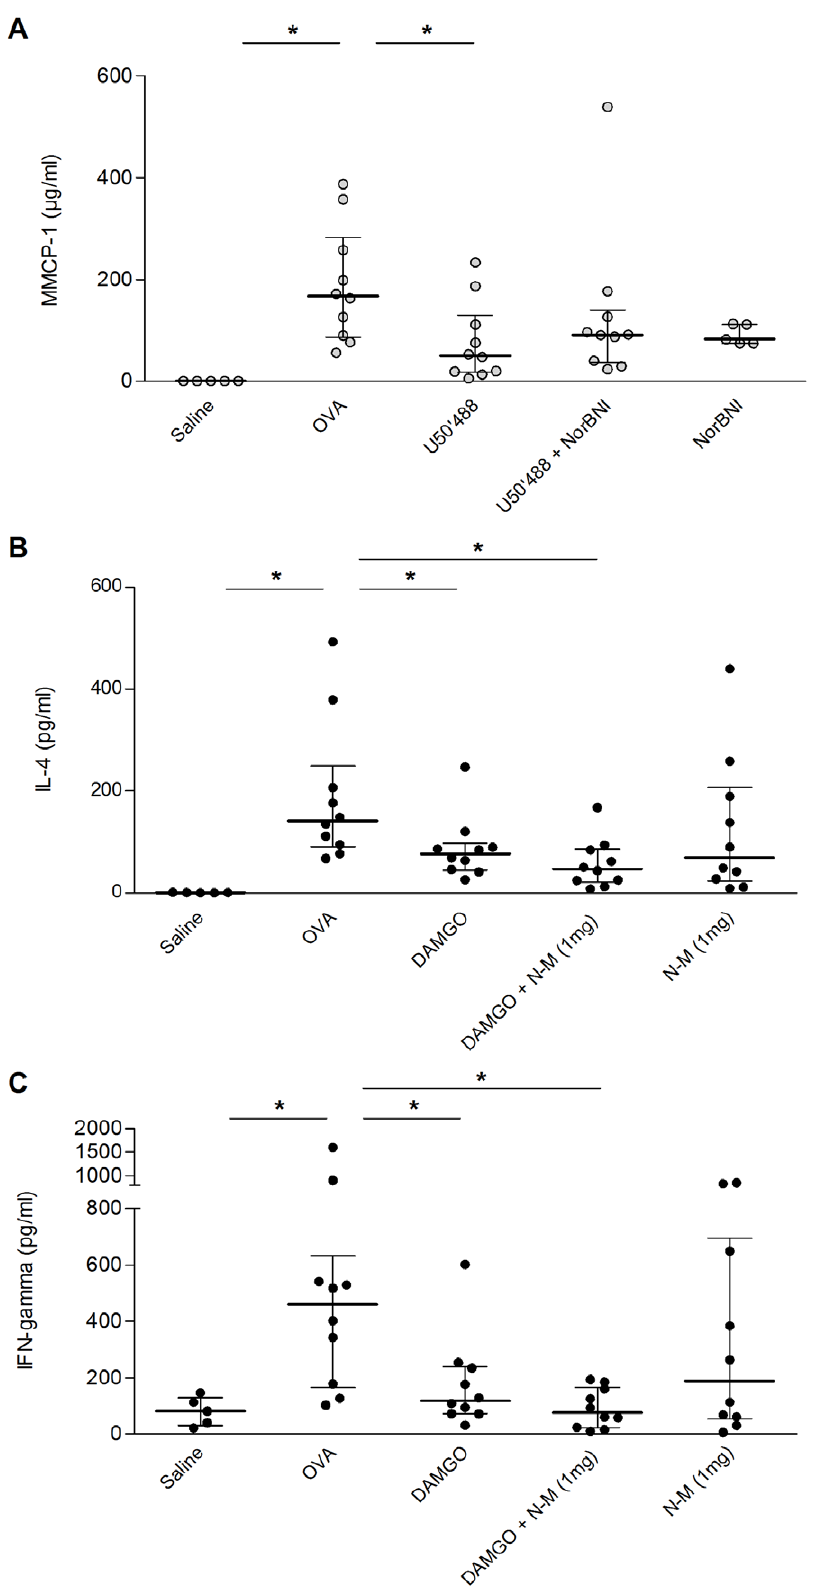
Figure 4. KOR-agonist (U50’488) and MOR-agonist (DAMGO) alleviate allergy related immune markers in OVA-allergic mice. OVA- sensitized mice were challenged with saline (Saline) or OVA (OVA) with or without pre-treatment. The graph shows the concentration of total plasma MMCP-1 ( A ) at sacrifice after subcutaneous treatment with 5 mg/kgBW KOR-agonist U50’488 (U50’488), with 20 mg/kgBW NorBNI (U50’488 + NorBNI),